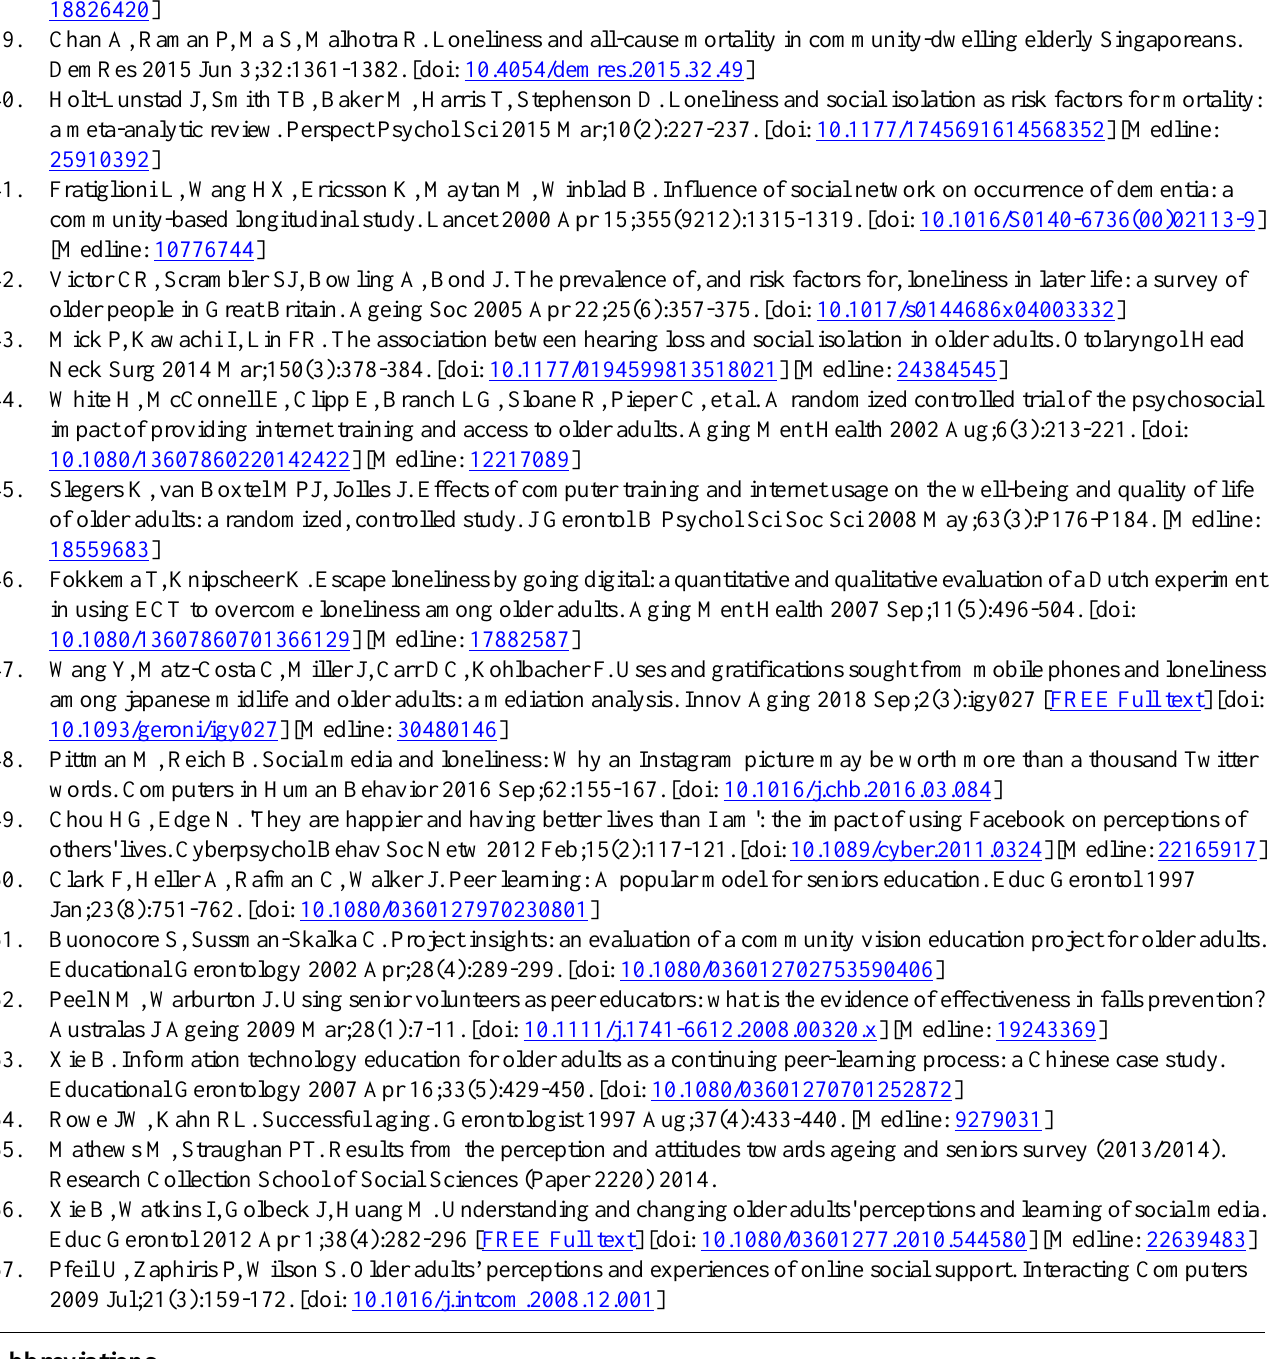
CHI: Community Health and Intergenerational ICT: information and communications technology SNS: social networking